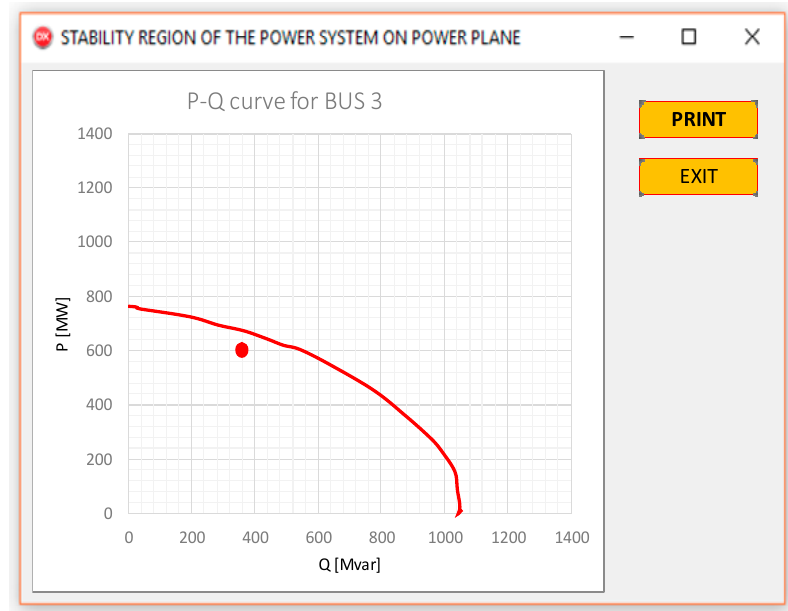
Figure 13. Operating region at Bus 3 when adjusting P 2 f .